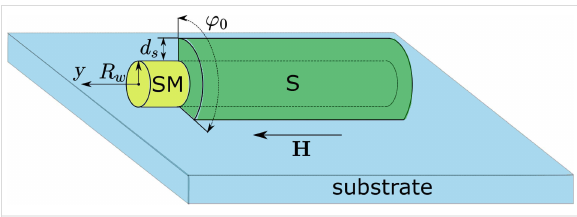
Figure 1: Schematic picture of the semiconducting wire (yellow) covered by the superconducting layer (green) placed on a substrate (light blue). R w , d s and φ 0 show linear and azimuthal dimensions. The magnetic field H is applied along the wire axis Oy while the Rashba spin–orbit vector is perpendicular to the substrate (not